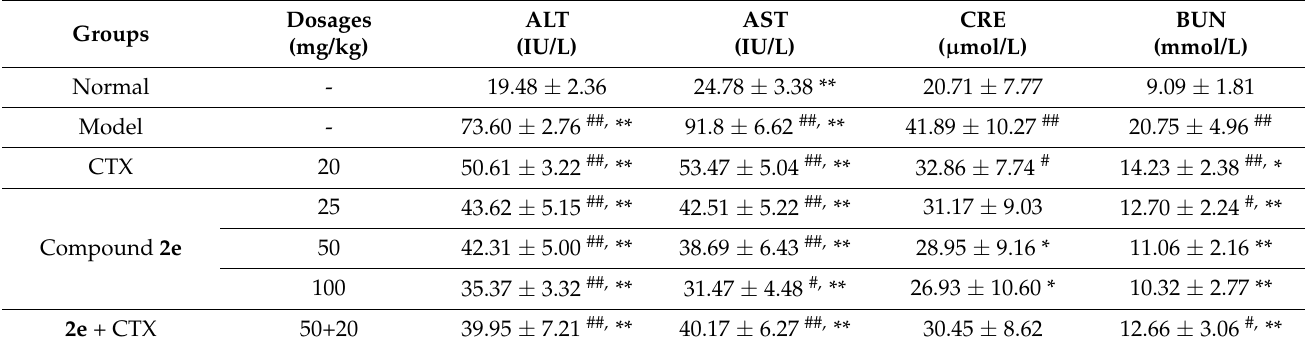
Table 4. Effects of compound 2e treatment on hepatic and renal